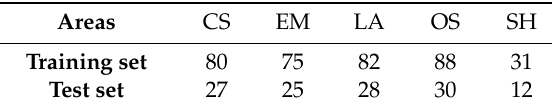
Table 4. Number of samples of each category.